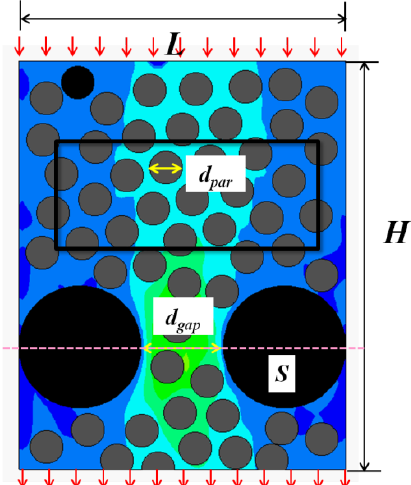
Figure 8. Simulation layout of SCC flow in a single channel.